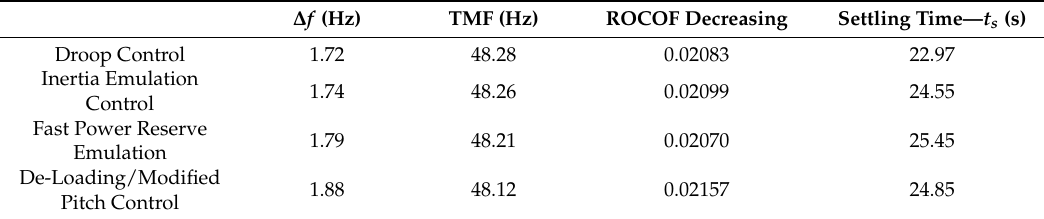
Table 3. Dynamic comparison in high wind speed case.